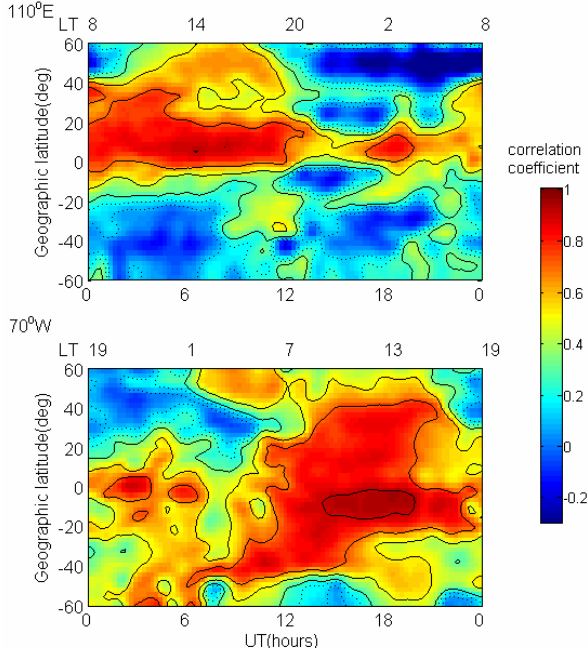
Fig. 4. The diurnal correlation coefficient between solar flux F10.7 and TEC value for Fig. 4. The dirunal correlation coefficient between solar flux F10.7 and TEC value for the longitude 110 ◦ E and 70 ◦ W during October the longitude 110°E and 70°W during October 2003.